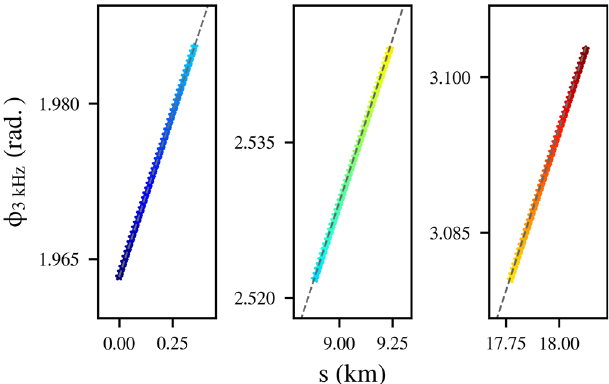
FIG. 21. Phase evolution of the excitation at 3 kHz as a function of the bunch position for three trains of 48 bunches in the LHC ring. The dashed gray line represents the expected dephasing computed from Eq. (A1).